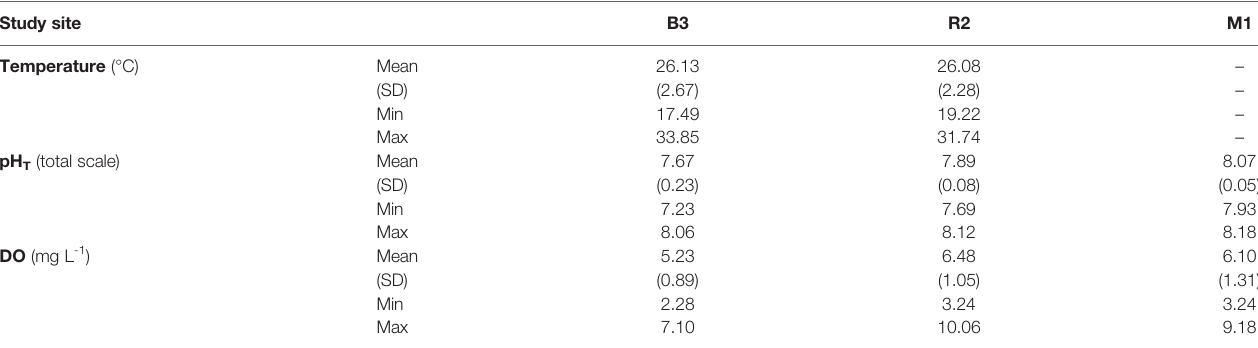
TABLE 1 | Main environmental parameters measured at Bourake ́ (B3) and the stations M1 and R2. Study